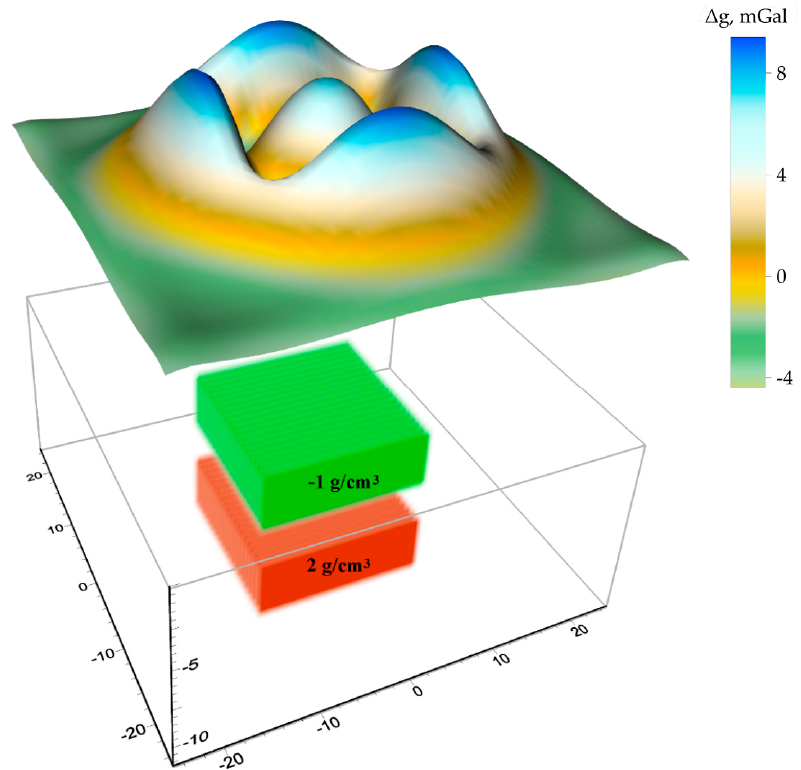
Figure 3. Direct gravity problem for inhomogeneous density parallelepiped: the 3D density distribution model 𝜌(𝑥, 𝑦, 𝑧) and calculated model field.